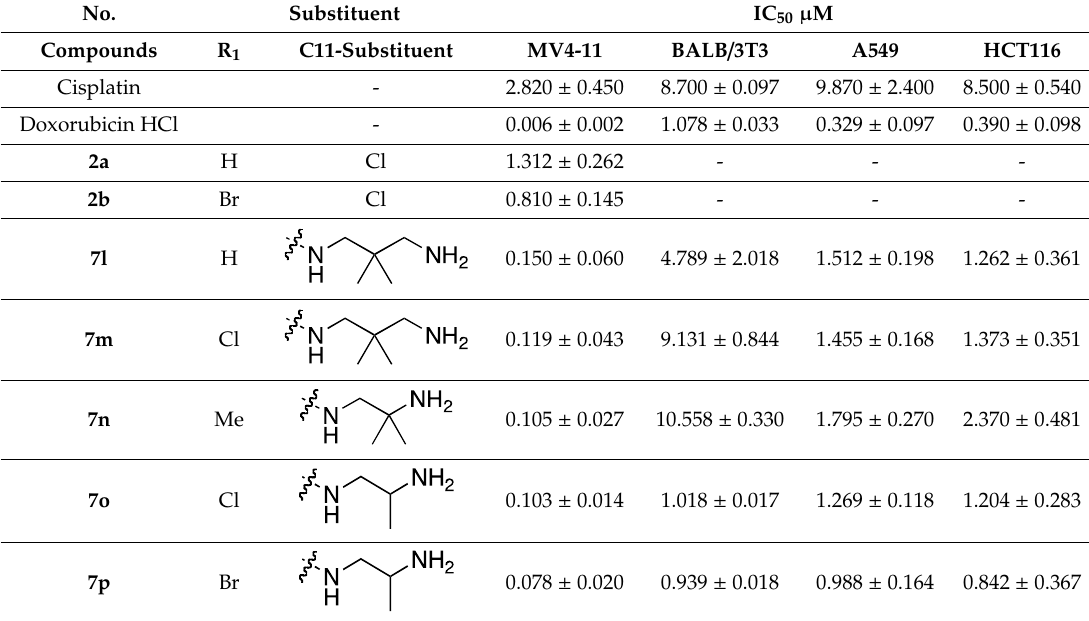
2b Br Cl 0.810 ± 0.145